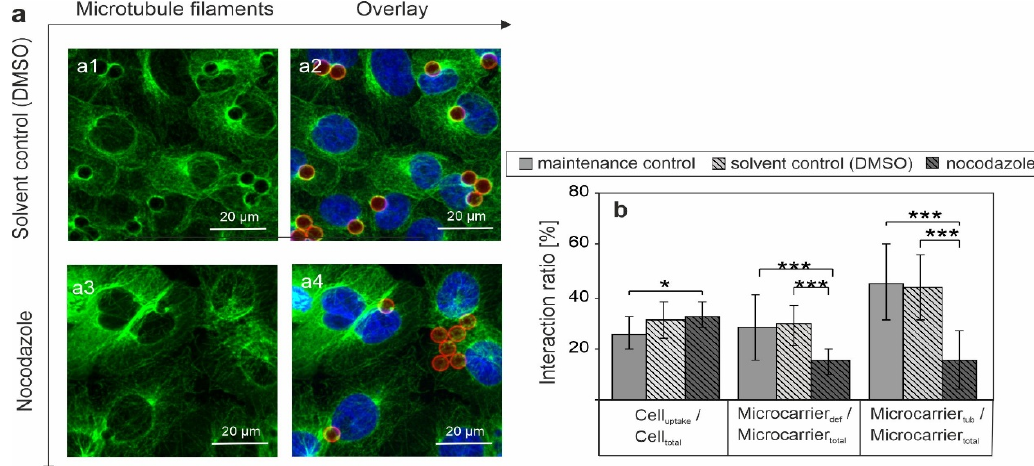
Figure 7. Immunofluorescence analysis of microtubule filaments in Vero cells after 4 h of incubation with SLB microcarriers and nocodazole (NOC). The solvent control (DMSO, a1 , a2 ) or nocodazole ( a3 , a4 ) were added together with SLB microcarriers to Vero cells followed by replacement to maintenance medium after 4 h of incubation followed by an additional incubation time of 2 h. Nuclei were stained with DAPI (blue), microtubule filaments with anti- α -tubulin (green), and microcarriers with RITC (red). In ( b ) SLB microcarriers were added in maintenance medium (maintenance control), in the solvent control (solvent DMSO) or nocodazole medium to Vero cells. Immunofluorescence samples were subjected to quantification of cell and microcarrier properties. Data are presented as the ratio of cells with at least one internalized microcarrier to the total number of cells (Cell uptake /Cell total ), the ratio of microcarrier-associated with deformed nuclei to total number of microcarriers (Microcarrier def /Microcarrier total , and the ratio of internalised microcarrier, which are associated with microtubule filaments (Microcarrier tub /Microcarrier total ), ( n = 3, five random microscopic fields were used for quantification t -test, * p < 0.05, *** p < 0.001). Image size: 75 µm × 75 µm.